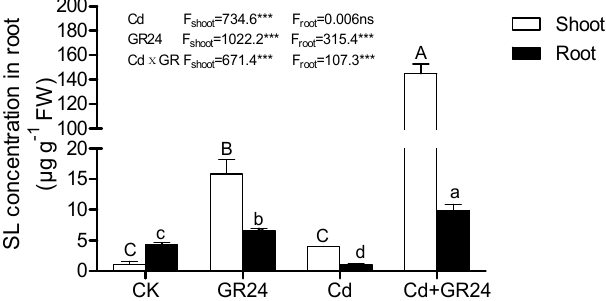
Figure 4. Effects of GR24 on the endogenous strigolactones in shoots and roots under Cd stress. Values are means ± SD ( n = 3). Lower-case letters represent significant differences in roots; upper-case letters represent significant differences in shoots. Different letters above the bars indicate significant differences at the 0.05 level according to Duncan’s multiple range test. * p < 0.05, ** p < 0.01, *** p < 0.001. ns: not significant.